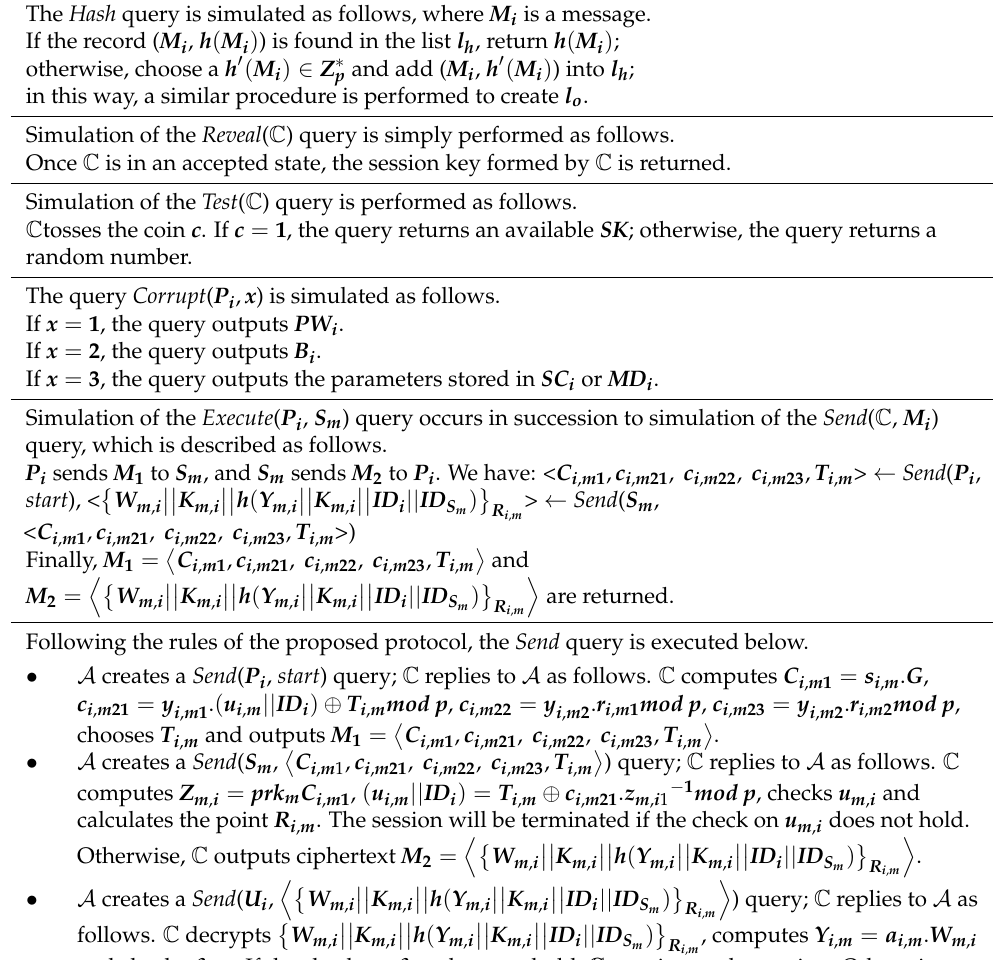
Table 2. Simulation of the Hash, Reveal, Test, Corrupt, Execute and Send oracle queries. The Hash query is simulated as follows, where M i is a